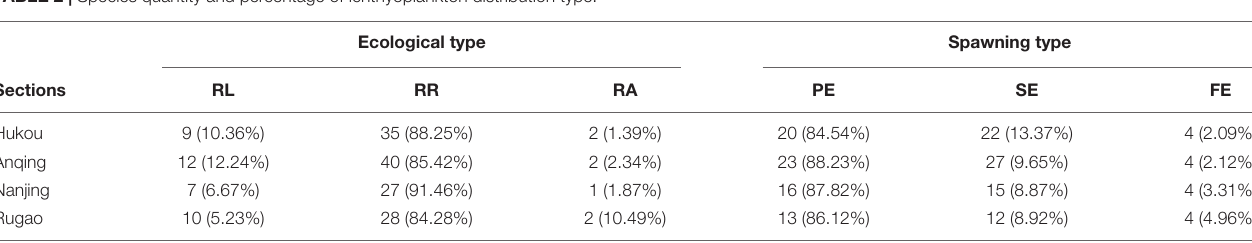
A comparison of the ichthyoplankton density at the three sampling sites of each section showed that the average density at the L site was greater than that at the R site, which was